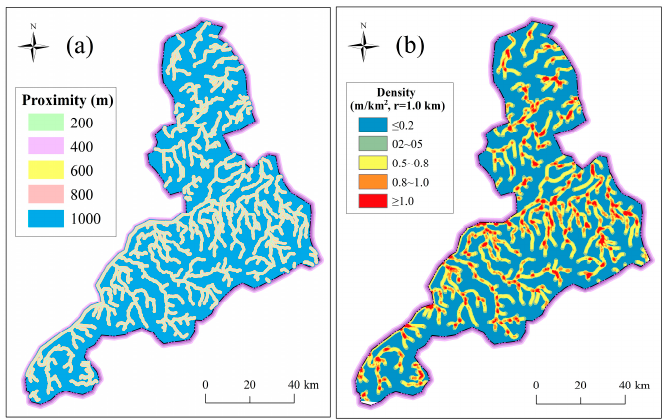
Figure 11. Characteristics of river system: ( a ) river proximity; and ( b ) river density.